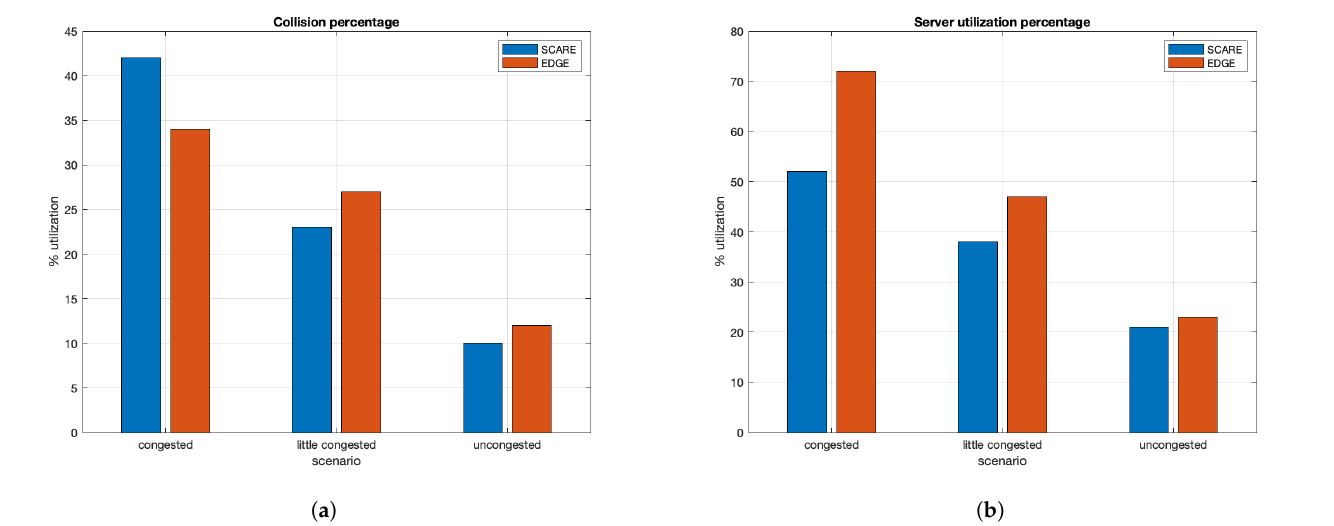
Figure 11. ( a ) Collision percentage vs. traffic congestion; and ( b ) server utilization percentage vs. traffic